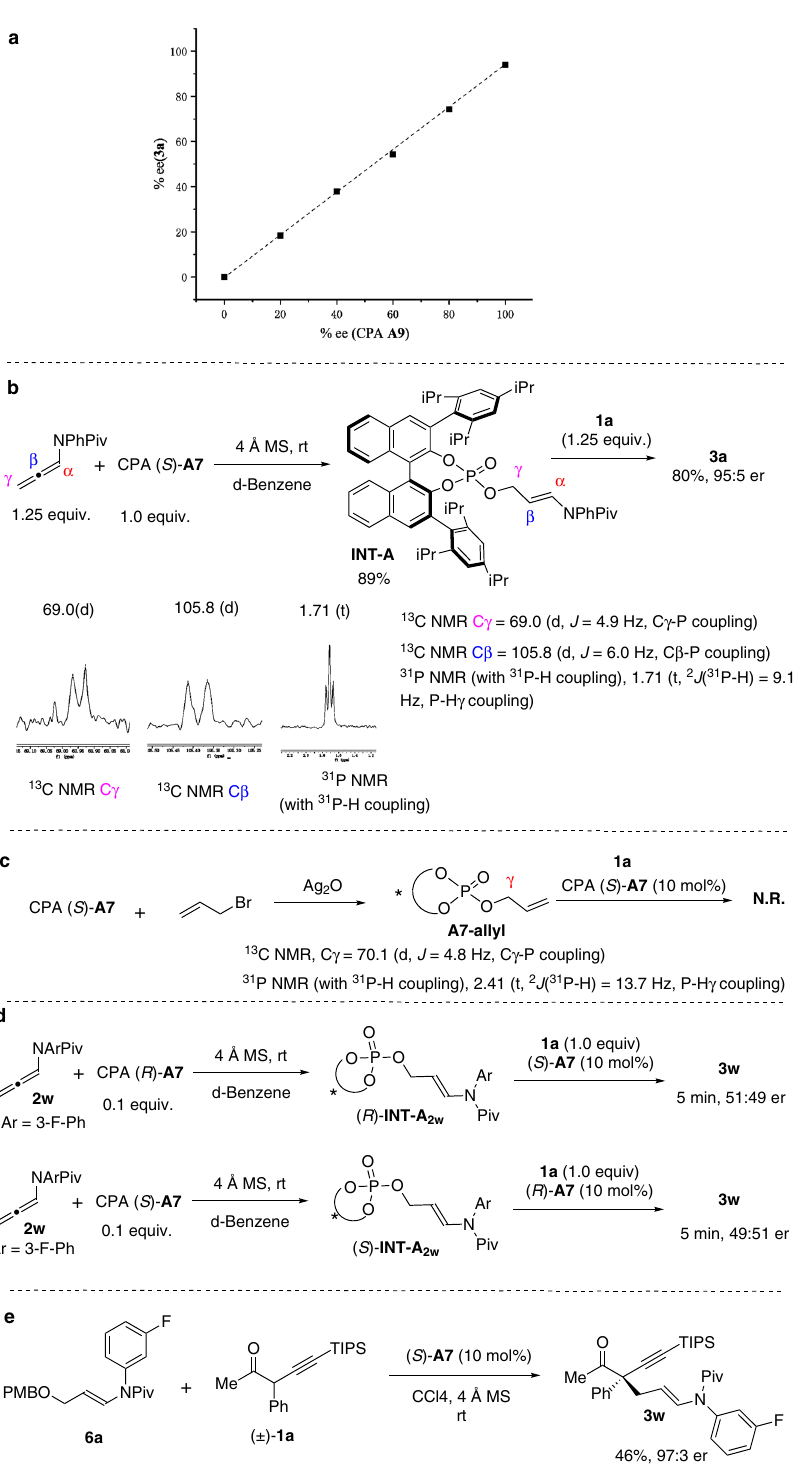
Fig. 6 Investigation of the asymmetric induction mechanism. a Nonlinear effect study. b Detection and characterization of the reaction intermediate. c Preparation of allyl phosphate of CPA A7 and its reaction with ketone 1a under the standard conditions. d Cross experiment of INT-A 2w . e Asymmetric reaction of allyl benzyl ether 6a with ketone 1a under the standard